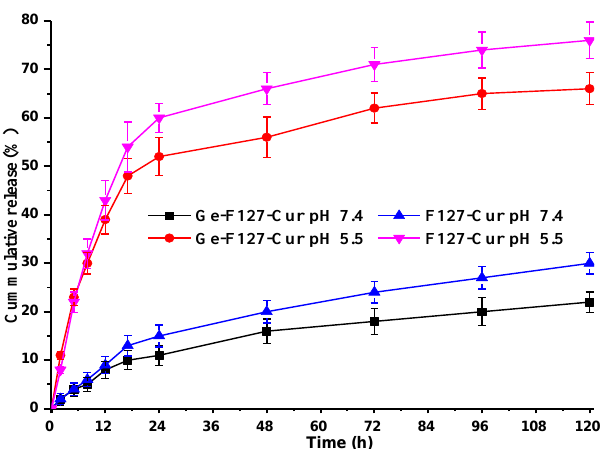
Figure 8. Release profiles of the encapsulated curcumin in Ge-F127 and F127 nanoparticles at two physiological conditions, pH 7.4 and 5.5.